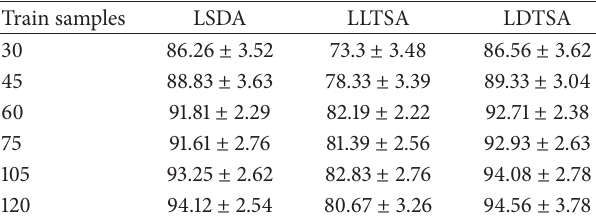
Table1:Averageclassificationrates(%)andstandarddeviationsICL plant leaf database.